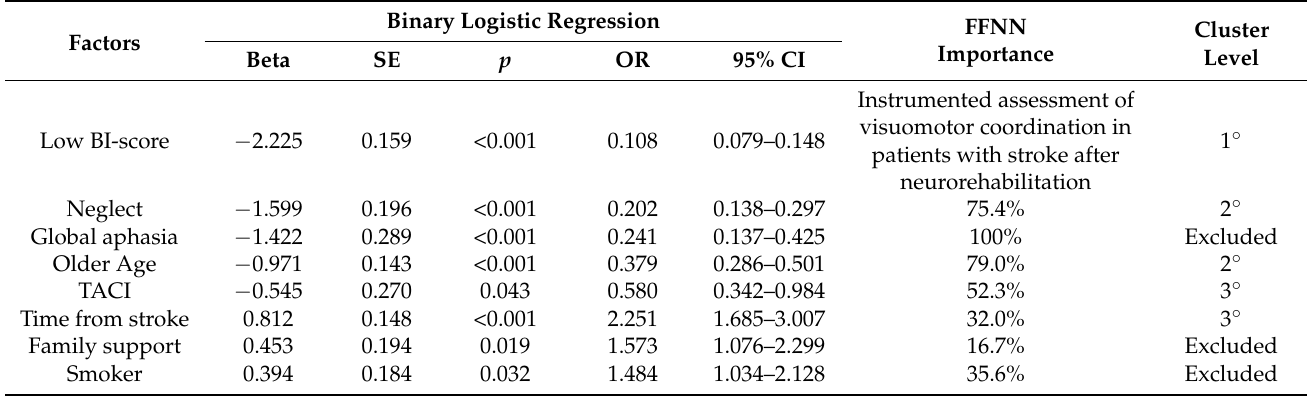
Table 2. Variables entered into the model of binary linear regression (Beta: coefficients, SE: standard error, p : probability value for rejecting null hypothesis, OR: odds ratio, 95%CI: confidence interval at 95%), their relevant normalized percentage importance in feed forward neural network (FFNN), and the level at which they compare to the classification tree of cluster analysis. Factors